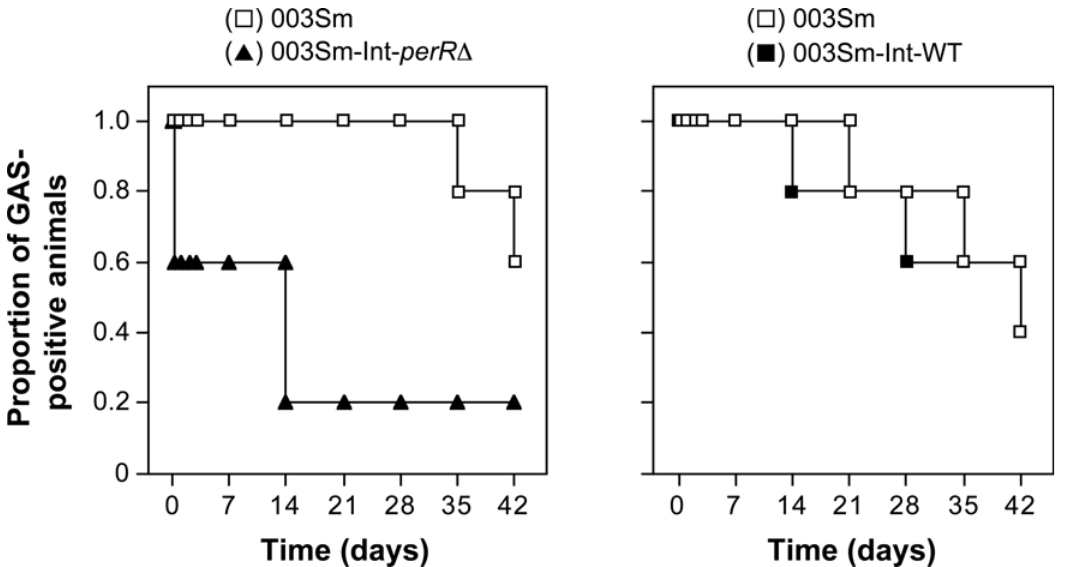
Figure 5. Time-to-clearance of wild-type strain 003Sm versus PerR mutant strain 003Sm-Int- perR D (left panel) or 003Sm versus PerR-expressing strain 003Sm-Int-WT (right panel) in two groups of five co-infected baboons, respectively. The proportion of animals that yielded positive throat cultures for each of the two co-infecting strains in each group is shown. In the left panel, note the rapid clearance of the perR mutant strain 003Sm-Int- perR D (closed triangles) versus the persistence of the wild-type parent strain (open squares) in the same animals. In the control group shown in the right panel, persistence of the PerR-expressing strain 003Sm-Int-WT (closed squares) was similar to that of the wild-type strain 003Sm (open squares).